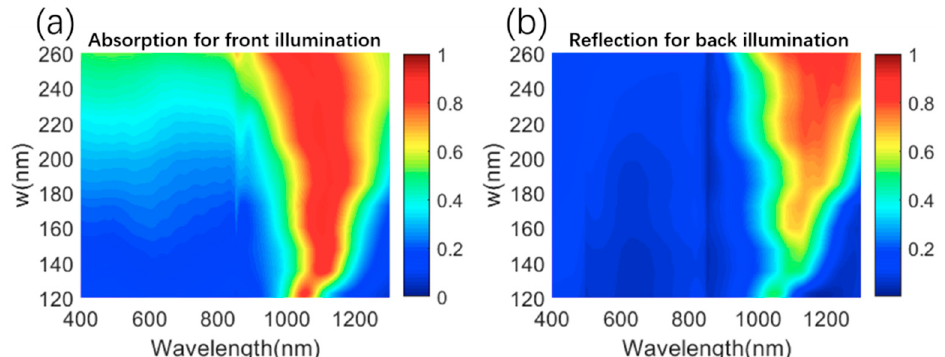
Figure 8. ( a ) Simulated absorption spectra of the metasurface composed of Ti/Al 2 O 3 /Cu with various w for front illumination. ( b ) Simulated absorption spectra of the metasurface composed of Ti/Al 2 O 3 /Cu with various w for back illumination.